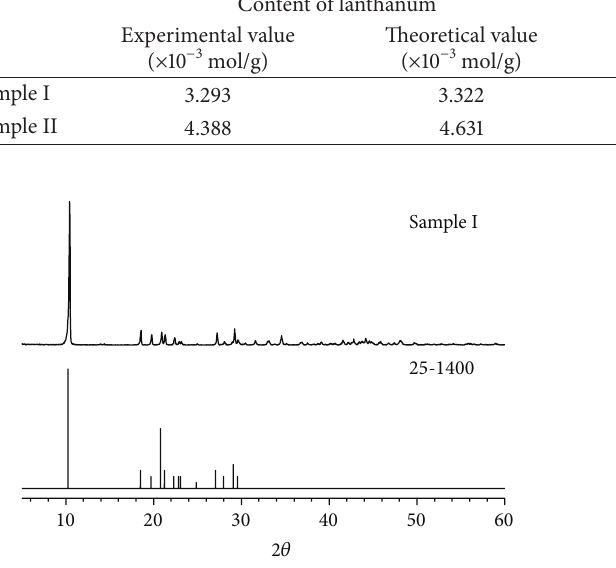
Figure 2: The XRD patterns of sample I and standard La 2 (CO 3 ) 3 ⋅ 8H 2 O from ICDD PDF2-2004 (card number: 25-1400). Match degree: 92.0%.